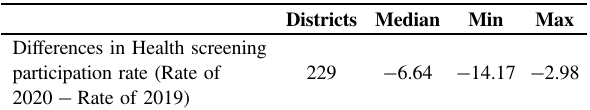
Table 2 Descriptive statistics of health screening participation